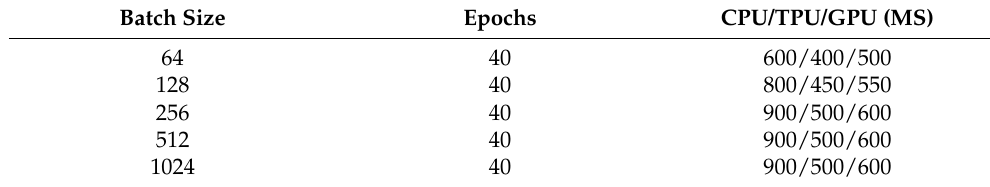
Table 9. Performance of CPU/TPU/GPU Comparisons of the proposed ShuffleNet-Light